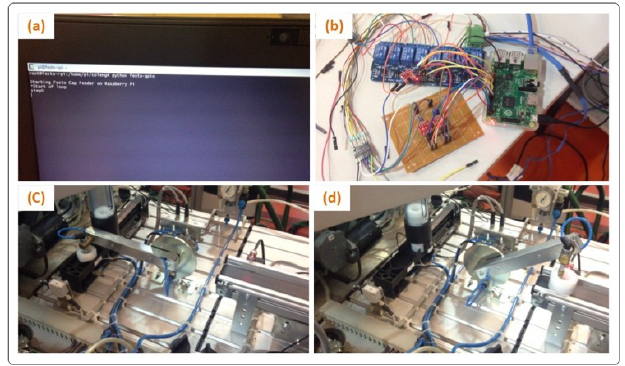
Figure 11. Clockwise from top left: ( a ) python script ( b ) interfacing with gear box ( c , d ) task execution by robotic arm.